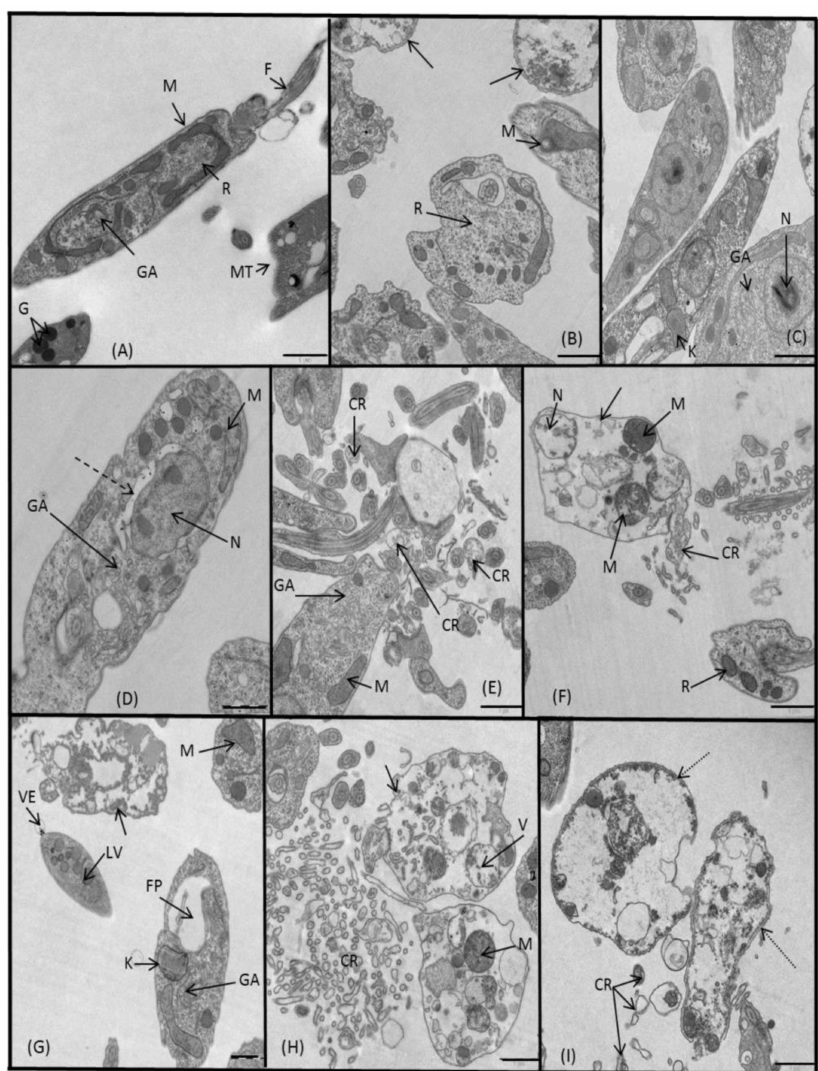
Figure 9. Ultrastructural images of L. infantum promastigotes treated for 72 h at IC 25 concentrations with: ( A ) untreated control, ( B , C ) 3, ( D , E ) 5, ( F ) 7, ( G , H ) 8, ( I ) 10 . (N) nucleus, (M) mitochondrion, (F) flagellum, (R) ribosomes, (MT) microtubule, (GA) Golgi apparatus, (G) glycosome, (K) kinetoplast, (CR) cellular rest, (V) vacuole, (LV) lipid vacuole, (VE) vesicle, (FP) flagellar pocket, (arrow) dead promastigote, (dashed arrow) nuclear membrane separation, (dotted arrow) lysed promastigote. In all cases scale bar corresponds to 1 µ